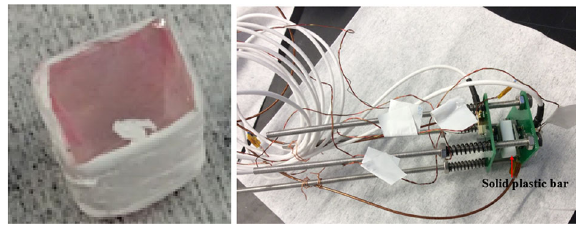
Fig. 13 Left: transparent plastic cube. Right: opaque solid plastic bar in between two SiPMs ∼ 18%, respectively, while the PMT gives 28.5% and